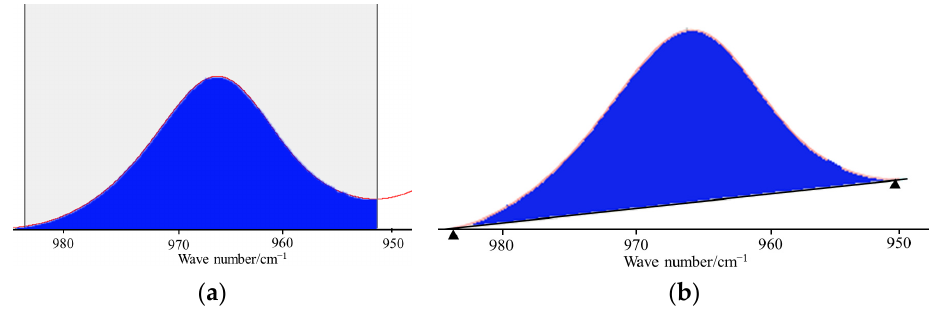
Figure 3. Schematic diagram of peak area. ( a ) Peak area before baseline correction. ( b ) Peak area after baseline